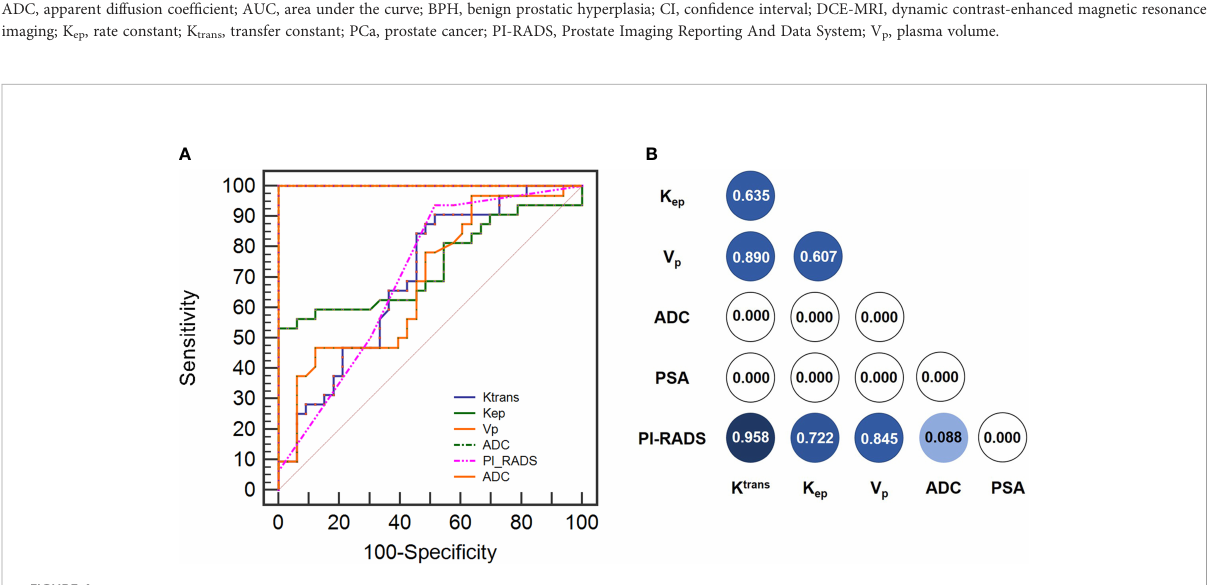
FIGURE 4 (A) Diagnostic performance of imaging parameters (K trans , K ep , Vp and ADC) and PI-RADS score in discriminating between PCa and BPH based on ROC curve analysis. (B) Delong analysis among imaging paramters (Ktrans, Kep, Vp and ADC) and PI-RADS score in discrimination between PCa and